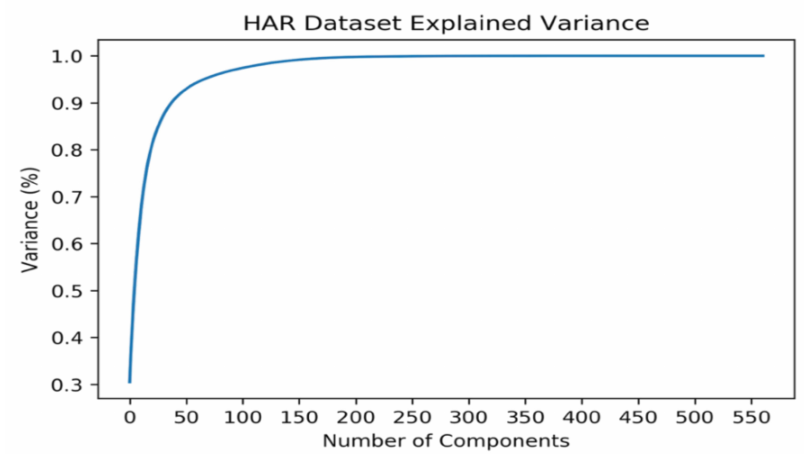
Figure 2. HAR dataset explained variance